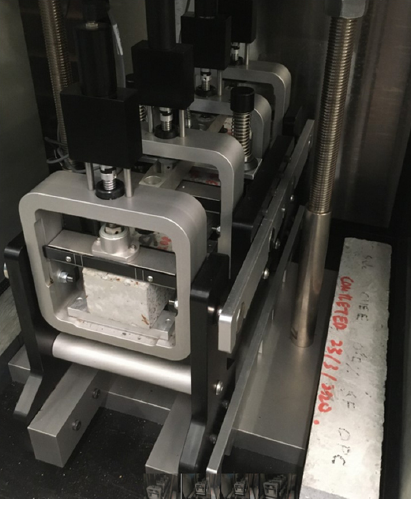
Figure 2. The 4PB testing apparatus in a temperature-controlled cabinet.